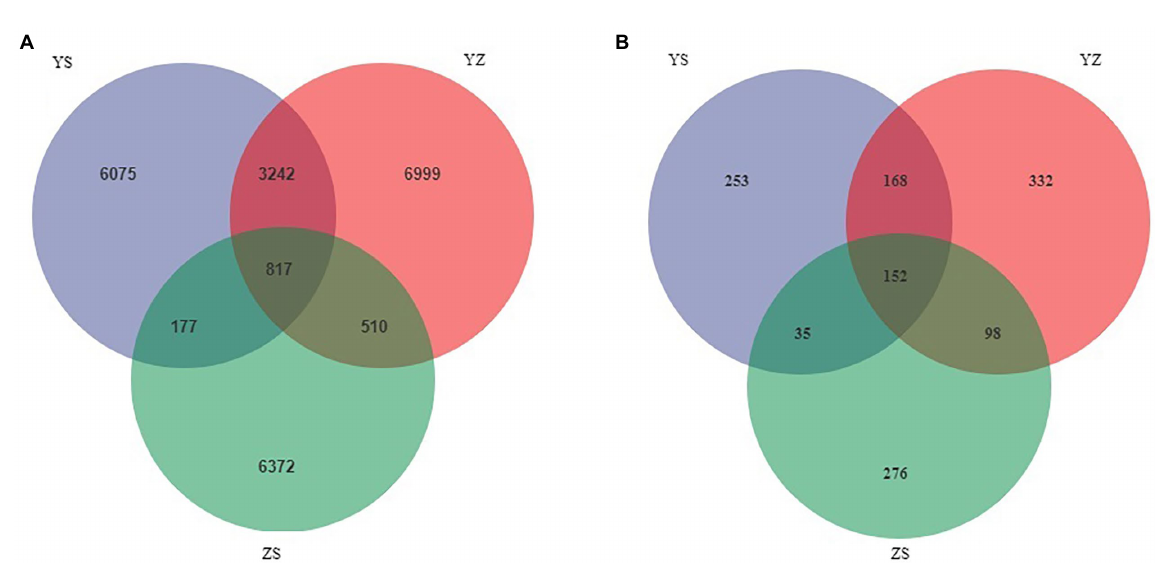
FIGURE 1 Venn diagrams showed the unique and shared OTU of litter microorganisms from three different samples. (A) unique and shared OTUs of leaf litter bacteria in three different samples; (B) unique and shared OTUs of leaf litter fungal in three different samples. YS: Populus × canadensis Moench; YZ: Populus × canadensis Moench- Pinus sylvestris var. mongolica ; ZS: Pinus sylvestris var. mongolica